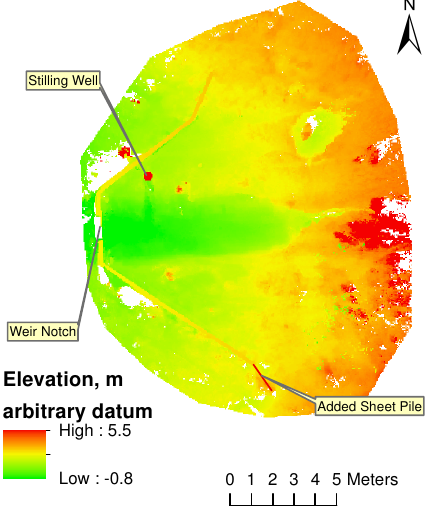
Fig. 3. Digital terrain model of the weir area. Elevations are in me- ters above an arbitrary “scanner datum”.